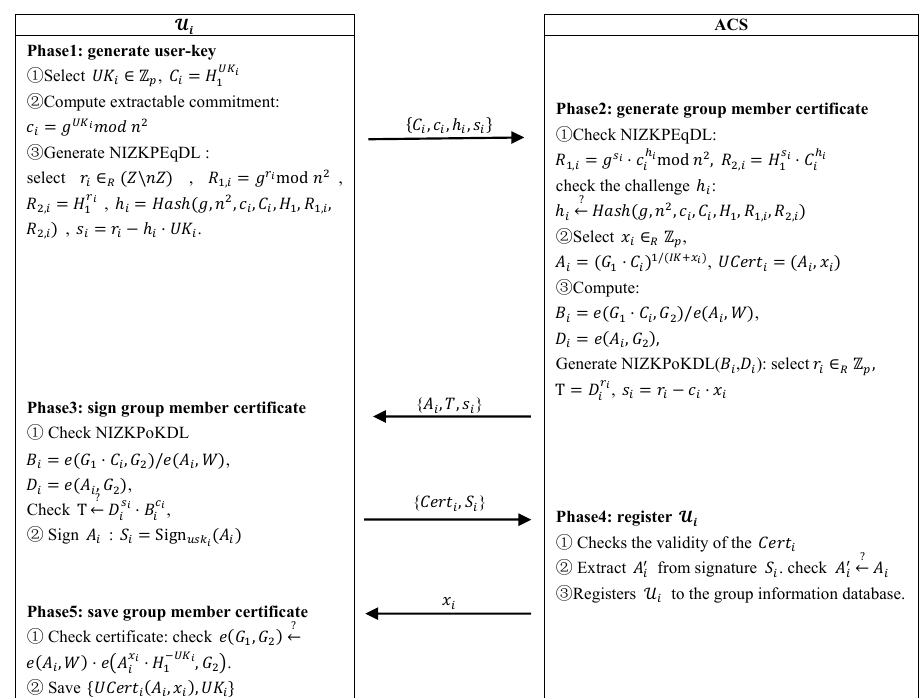
Figure 3. New user joining procedure.